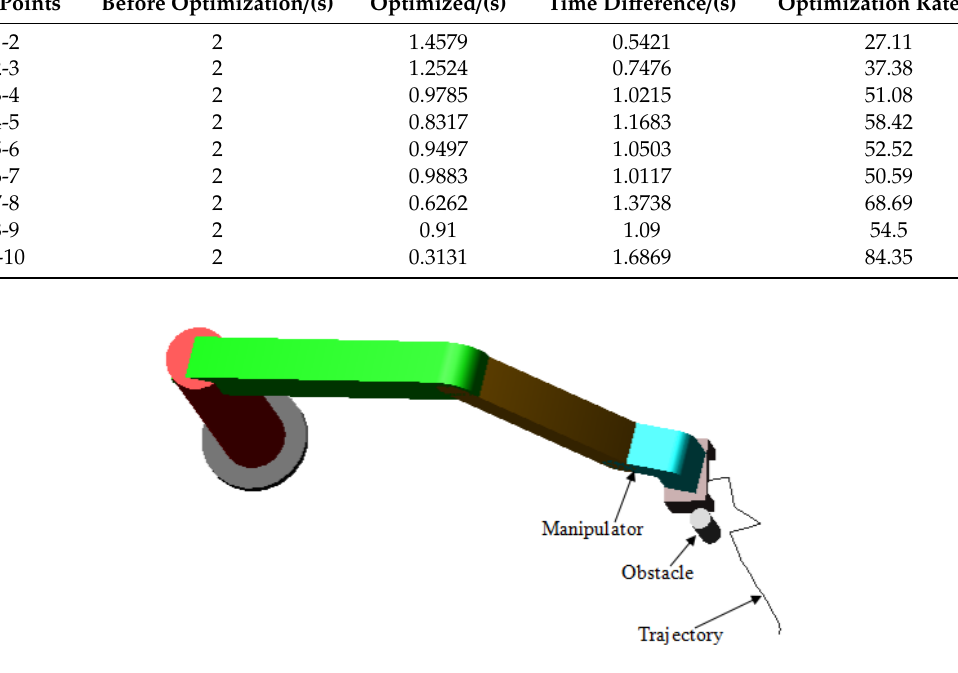
Figure 16. End state of the pickup manipulator.